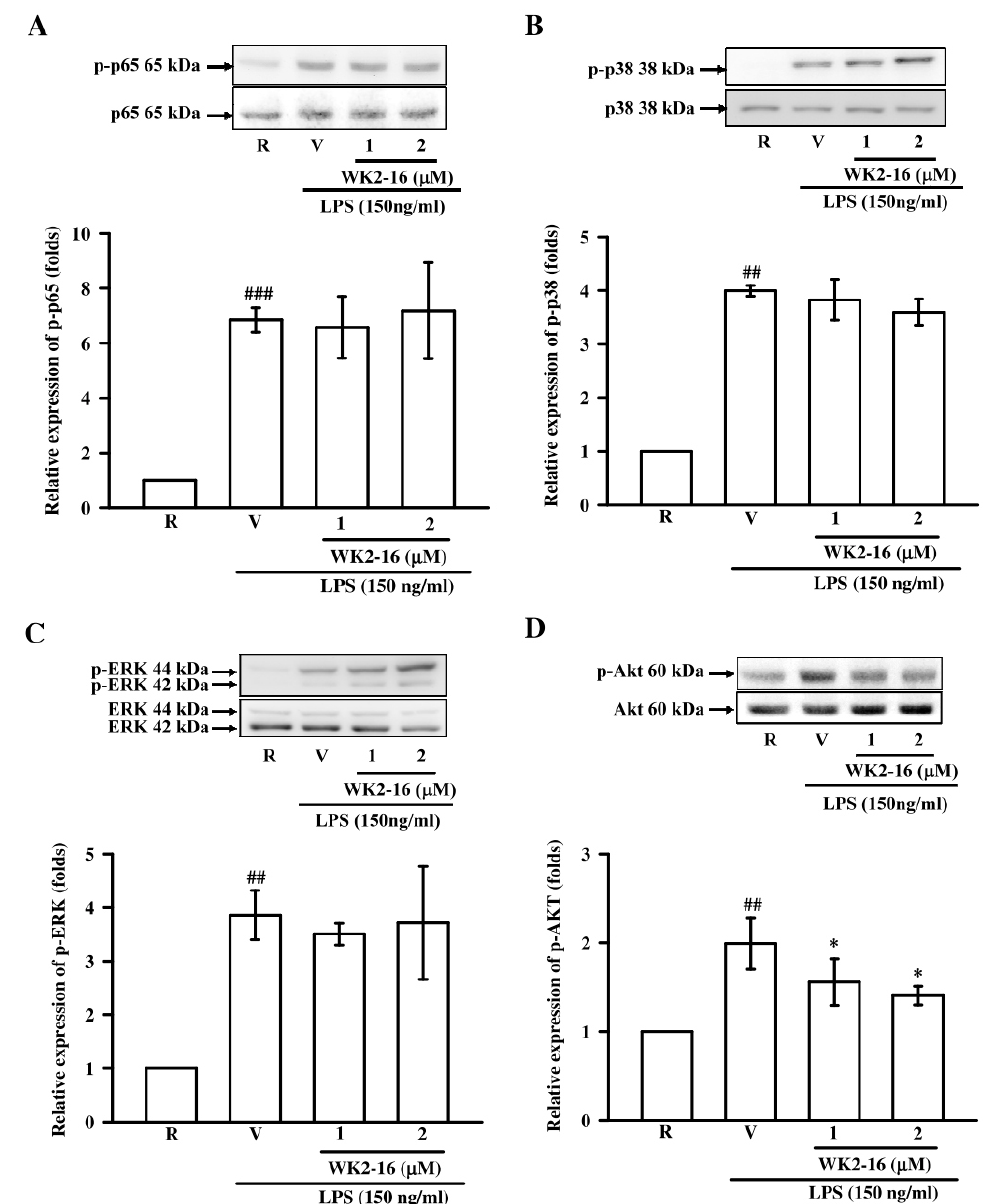
Figure 5. The effects of WK2-16 on LPS-activated pathway signaling in microglial BV-2 cells. Microglial BV-2 cells were pretreated with vehicle (DMSO) or WK2-16 (1 and 2 µ M) followed by LPS (150 ng/mL) stimulation for the indicated time. Phosphorylated levels of p65 ( A ), p38 ( B ), ERK ( C ), and Akt ( D ) in LPS-stimulated BV-2 cells treated with various concentration of WK2-16 were examined using Western blotting. Values are presented as the means ± SD from 3 independent experiments. R: resting; V: vehicle. p-p65: phosphorylated p65; p-p38: phosphorylated p38; p-ERK: phosphorylated ERK; p-AKT: phosphorylated AKT. ## p < 0.01, ### p < 0.001 compared to the resting group; * p < 0.05 compared to the LPS-stimulated group treated with vehicle (DMSO).